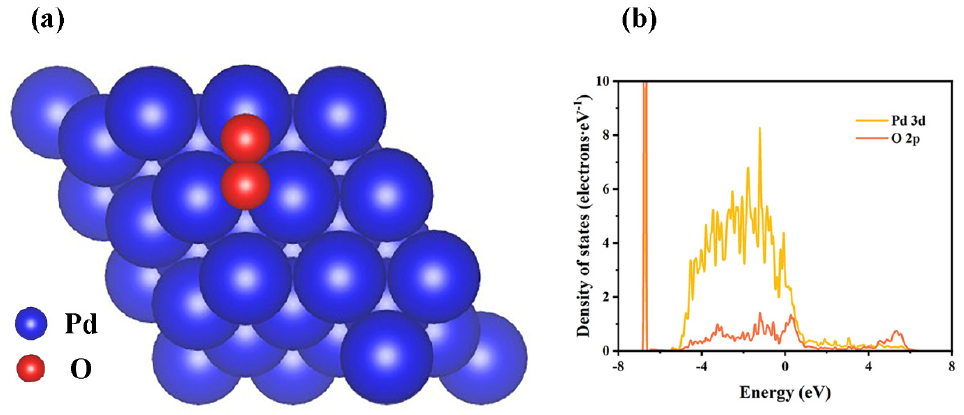
Figure 6. ( a ) O adsorbed on the t-f-b site of Pd (111); ( b ) PDOS distribution of the t-f-b site.